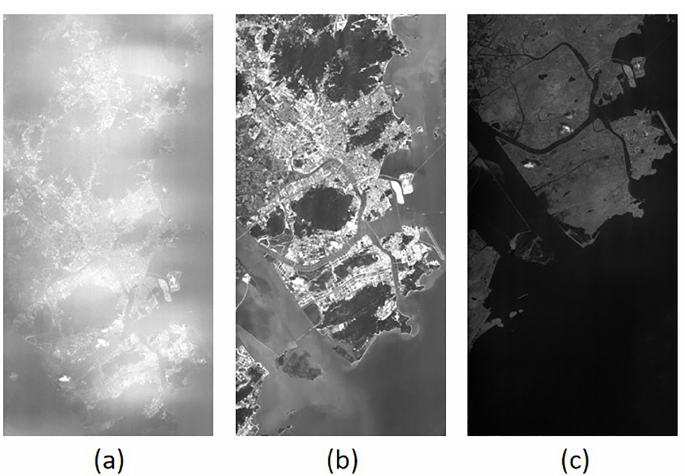
Figure 1. Three bands of an Orbita Hyperspectral Satellite (OHS) image. ( a ) is the 1st band, with a center wavelength of 466 nm; ( b ) is the 15th band, with a center wavelength of 686 nm; ( c ) is the 32nd band, with a center wavelength of 940